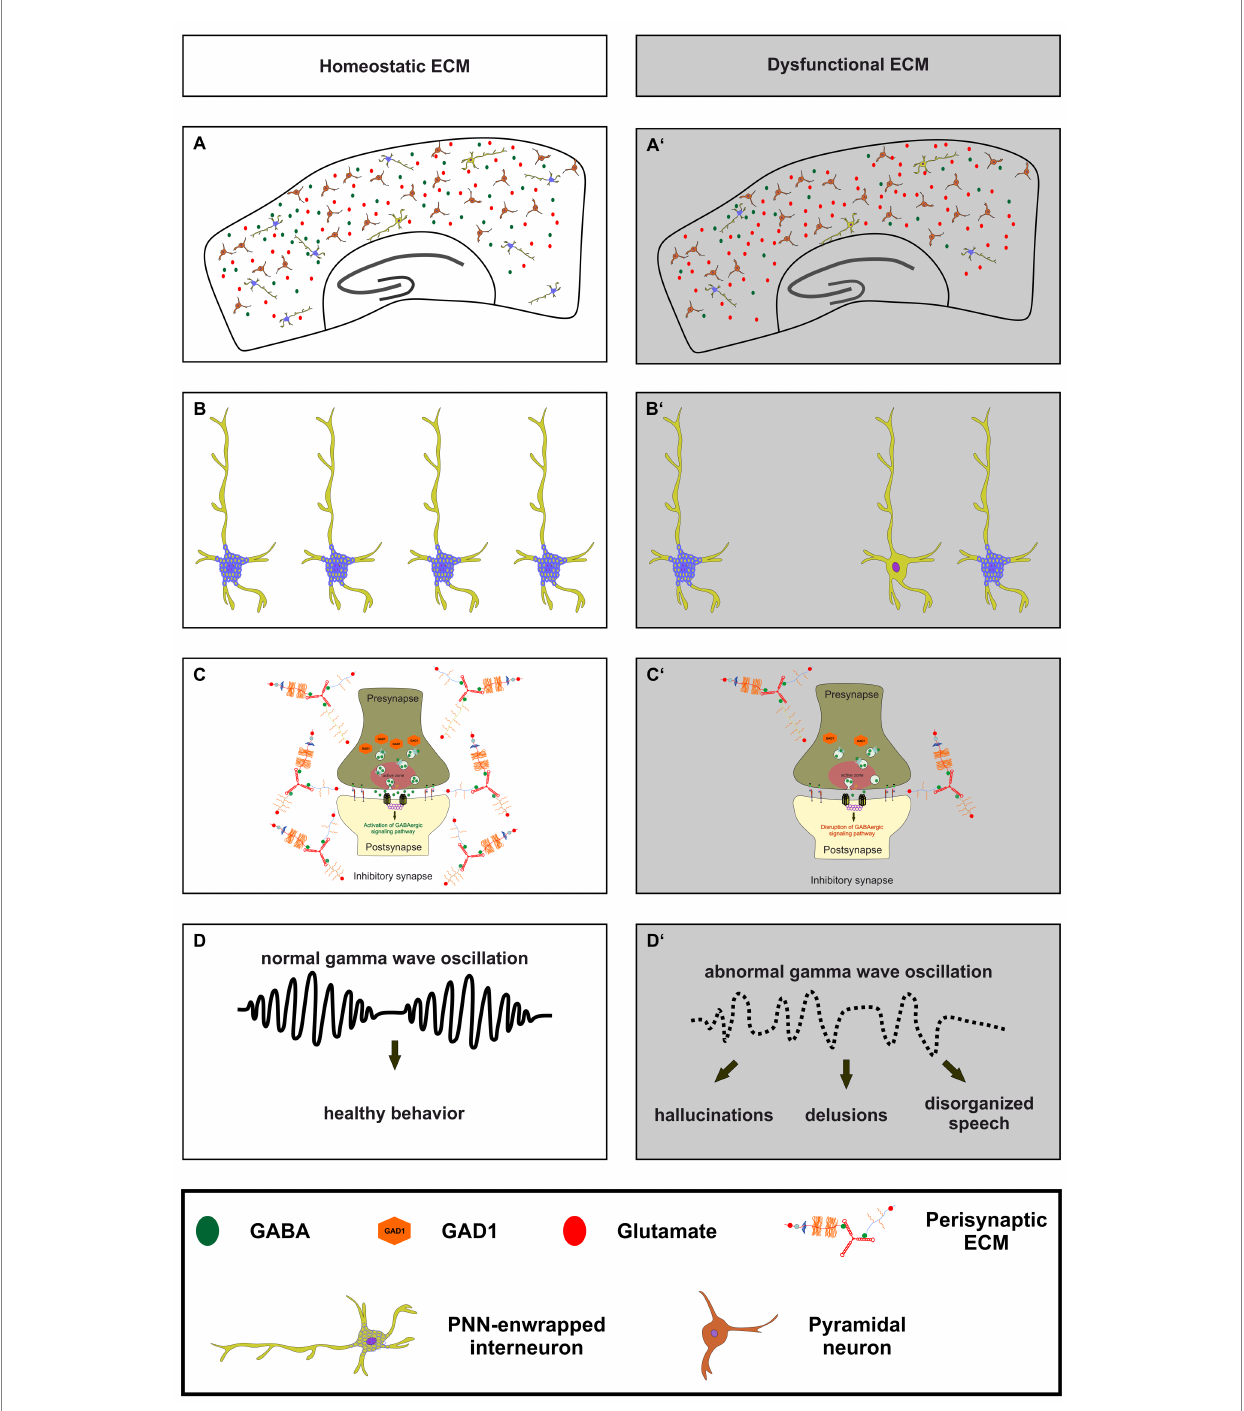
FIGURE 3 The importance of a homeostatic ECM for parvalbumin-expressing interneurons, synaptic transmission and ultimately healthy behavior. (A,A’) An illustration of a homeostatic ECM in the cortex with regulated E/I balance, where PNN enwrapped parvalbumin interneurons (light green with blue nets) and a few not PNN enwrapped parvalbumin interneurons are depicted. Pyramidal cells (dark red) and a balanced neurotransmitter release (GABA as green circles and glutamate as red circles) are also shown. In contrast, (A’) shows dysfunctional ECM in the cortex, where the number of PNNs and their enwrapped parvalbumin interneurons is reduced, and a disturbed E/I balance is indicated by reduced GABA and increased glutamate levels. (B,B’) In comparison to the homeostatic ECM, the dysfunctional ECM shows a lower number of parvalbumin interneurons and a reduced level of